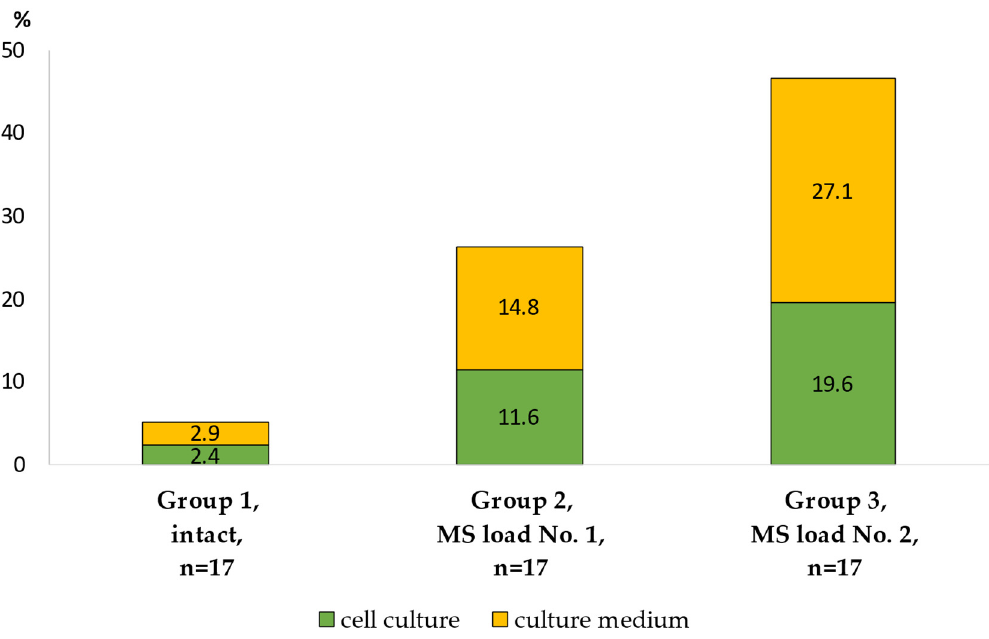
Figure 7. Integral response (Dv, %, p < 0.05) of the redox homeostasis parameters of alveolar macrophages to the model suspensions exposure.